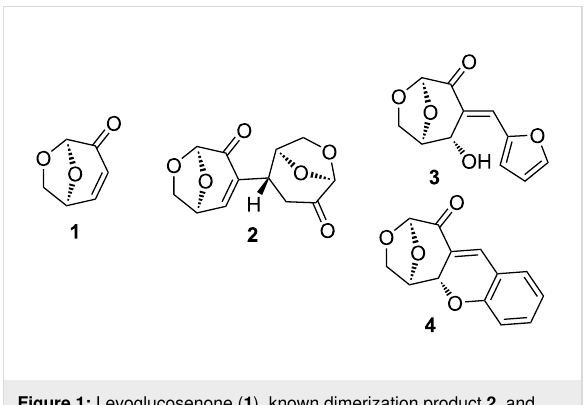
Figure 1: Levoglucosenone ( 1 ), known dimerization product 2 , and adducts 3 and 4